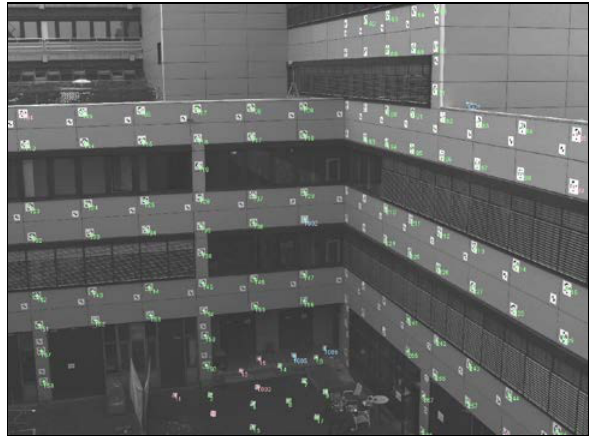
Figure 3: Test field at Beuth University of Applied Sciences The parameters of interior orientation (IO) and exterior orientation parameters (EO) were calculated during a bundle block adjustment. The point measurement was done automatically due to the use of coded markers. The significant estimated parameters are: - Principal point of autocollimation x H , y H Calibrated focal length c K and Radial-symmetric distortion coefficients k0, k1 and k2 Due to the usage of converging images the correlation between the IO parameters could be minimized. The highest correlation value was 15% between c k and k2.